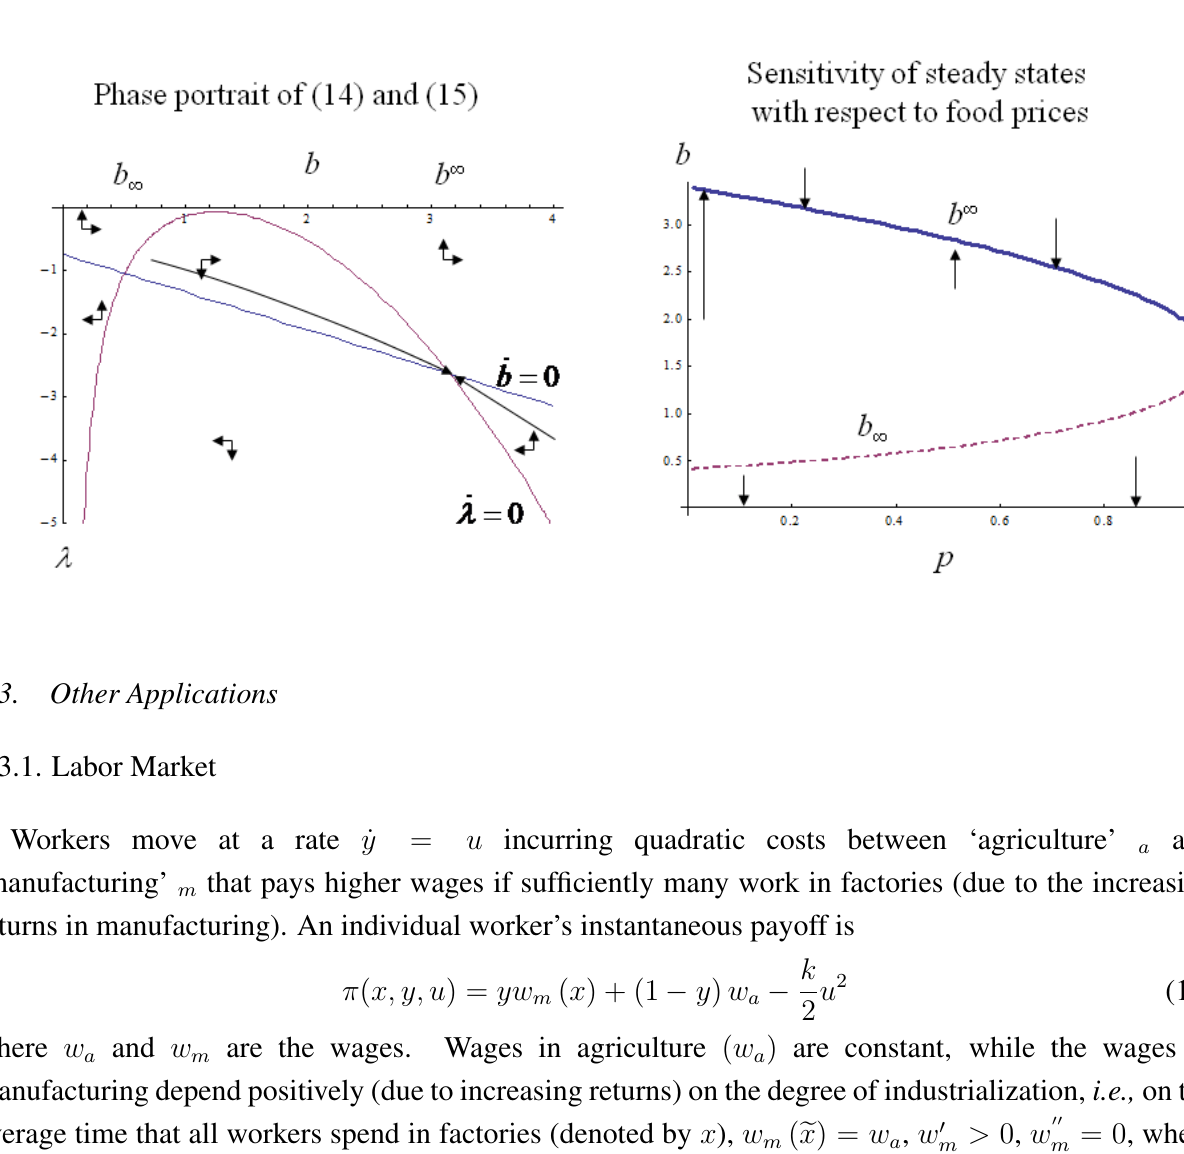
Figure 2. Example of specification (11) for the parameter values: r = 0 . 2 , p = 0 . 25 , α = 0 . 1 , β = 1 , k = 0 . 05 , v = 0 . 1 2